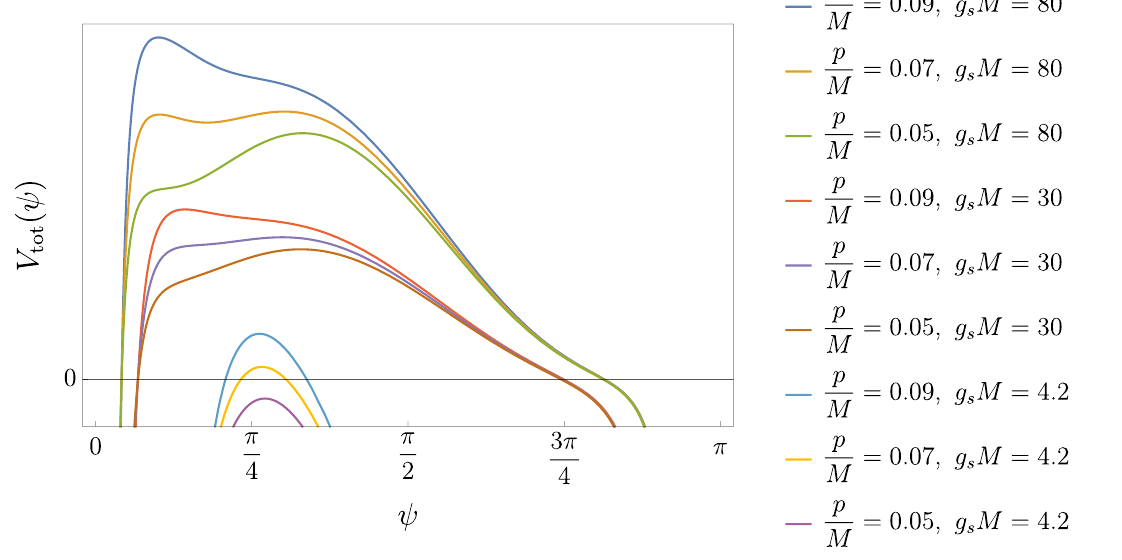
Figure 2. The potential V tot = V KPV ( ψ ) + V curv ( ψ ) for different values of p/M and g s M in units µ 5 = 1 . For each set of values of g s M , g s is chosen such that the potential is suitably